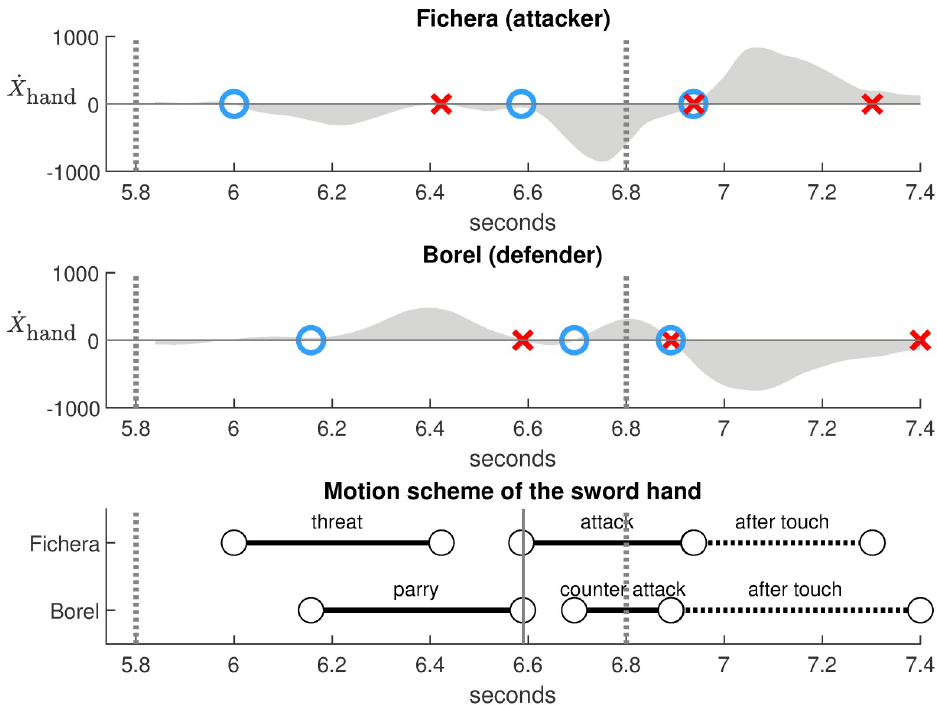
Fig 28. Horizontal velocity of the sword hand during a counter-attack in a duel Borel-Fichera with double touch (Challenge SNCF Re´seau, 2017). The touch at 6.8 seconds and the start 1 second before the touch are represented by dotted vertical lines. Each velocity bump (top and middle plots) is delimited between a blue circle and a red cross. The motion scheme (bottom plot) gives subtle indications on the performance of the athletes. It reveals that the attack of Fichera is synchronized with the end of the parry of Borel (continuous vertical line around 6.6 seconds), and the counter-attack of Borel appears more concise than the attack of Fichera. Source of the original video: [22].